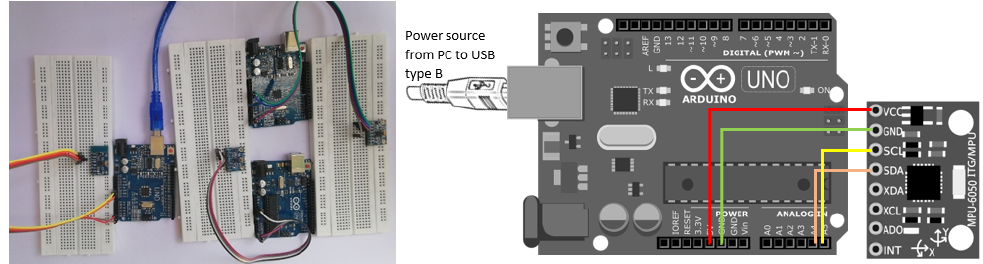
Figure 3. Hardware setup both physical and the schematic showing MPU-6050 connected to Ar- duino